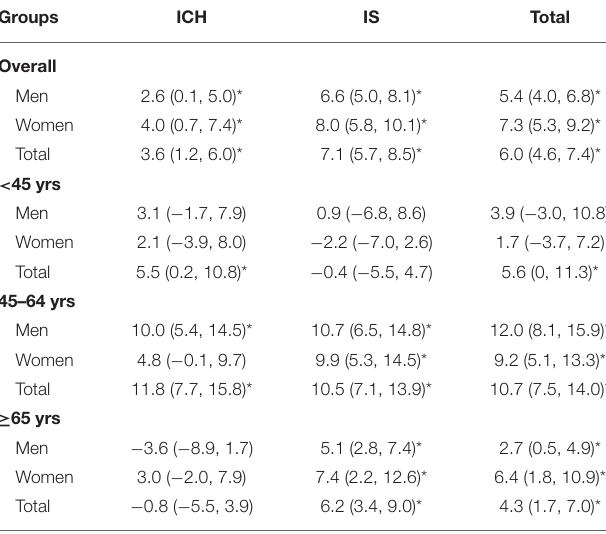
TABLE 3 | Annual proportion of changes in the age-standardized incidence of first-ever stroke by subtype and gender from 1992 to 2016. Groups ICH